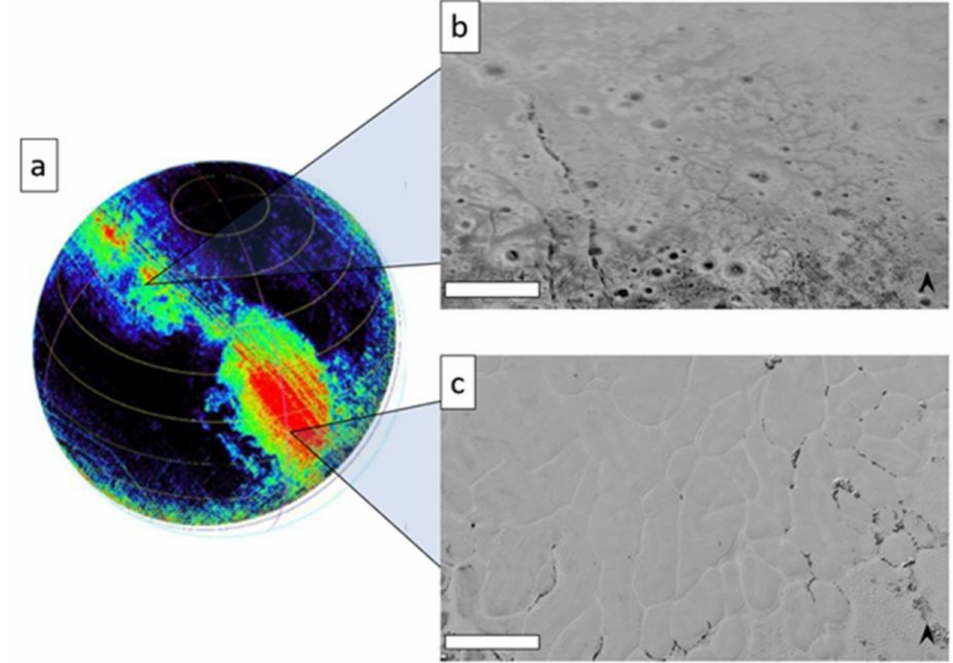
Figure 10. ( a ) CO concentrations on Pluto as observed by the LEISA instrument onboard the New Horizons spacecraft (see [84] on color scale and spectral measurements); ( b ) Venera Terra CO-CH 4 dominated region (scale bar 100 km); ( c ) central Sputnik Planitia basin with CO-N 2 ices (scale bar 75